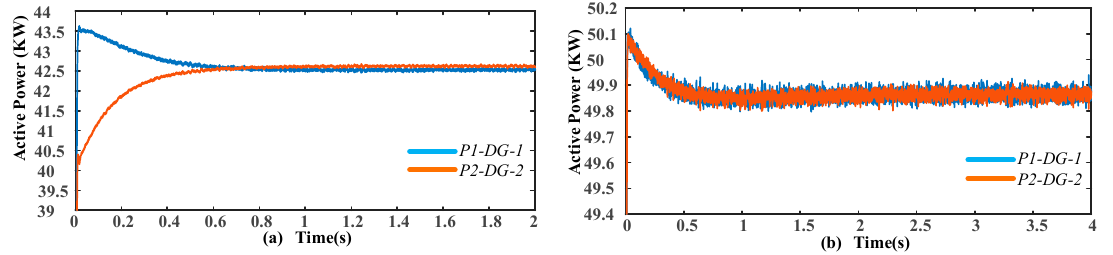
Figure 15. ( a ) Inverter terminal and load voltages for the conventional control scheme; ( b ) inverter terminal and load voltages for proposed control scheme.